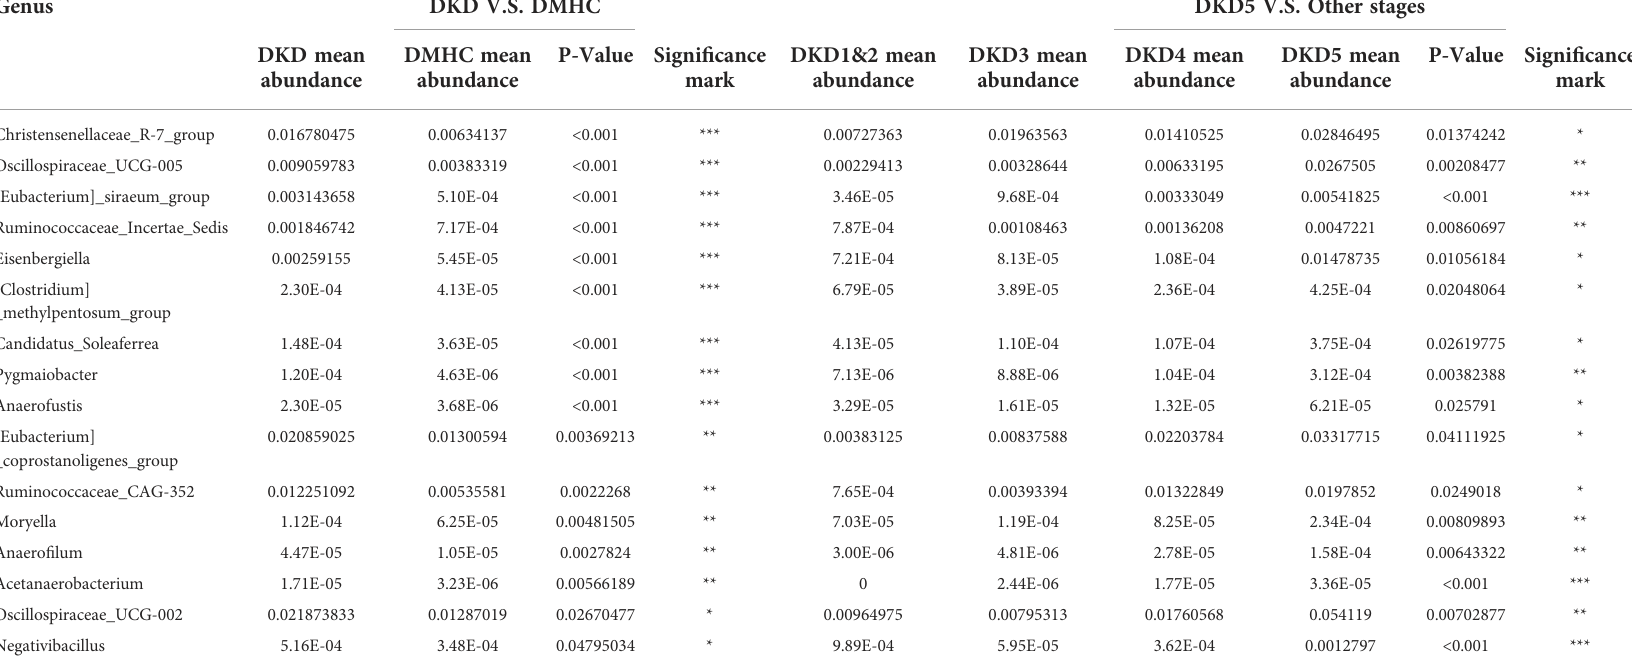
TABLE 2 The potentially harmful signi fi cantly accumulated genus shared by both DKD when compared with DMHC and DKD5 when compared with other DKD stages.